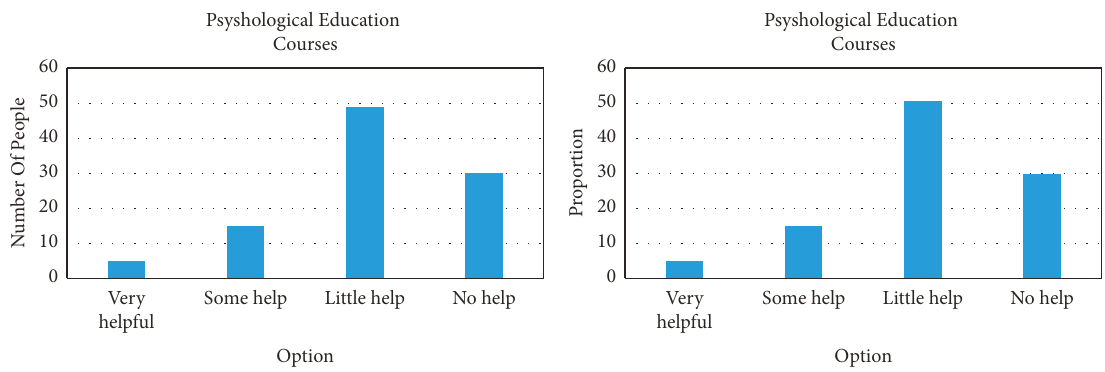
Figure 5: Whether psychoeducational courses are helpful in